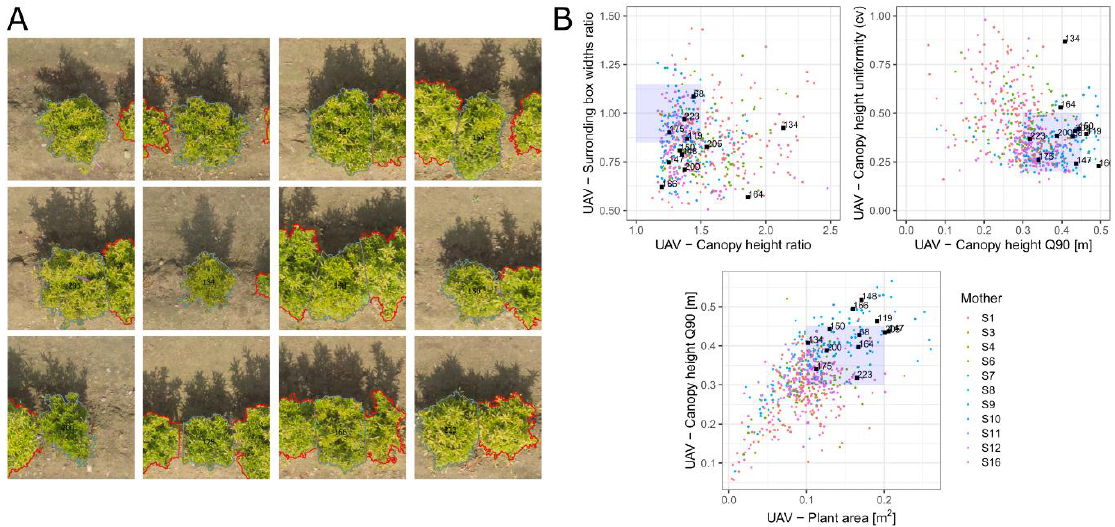
Figure 8. ( A ) Sarcococca plants selected (blue border) in the field identified by a unique ID (SarcoE2) and ( B ) comparison with the rest of the plants. The blue rectangle corresponds to the defined “ideal” selection criteria.